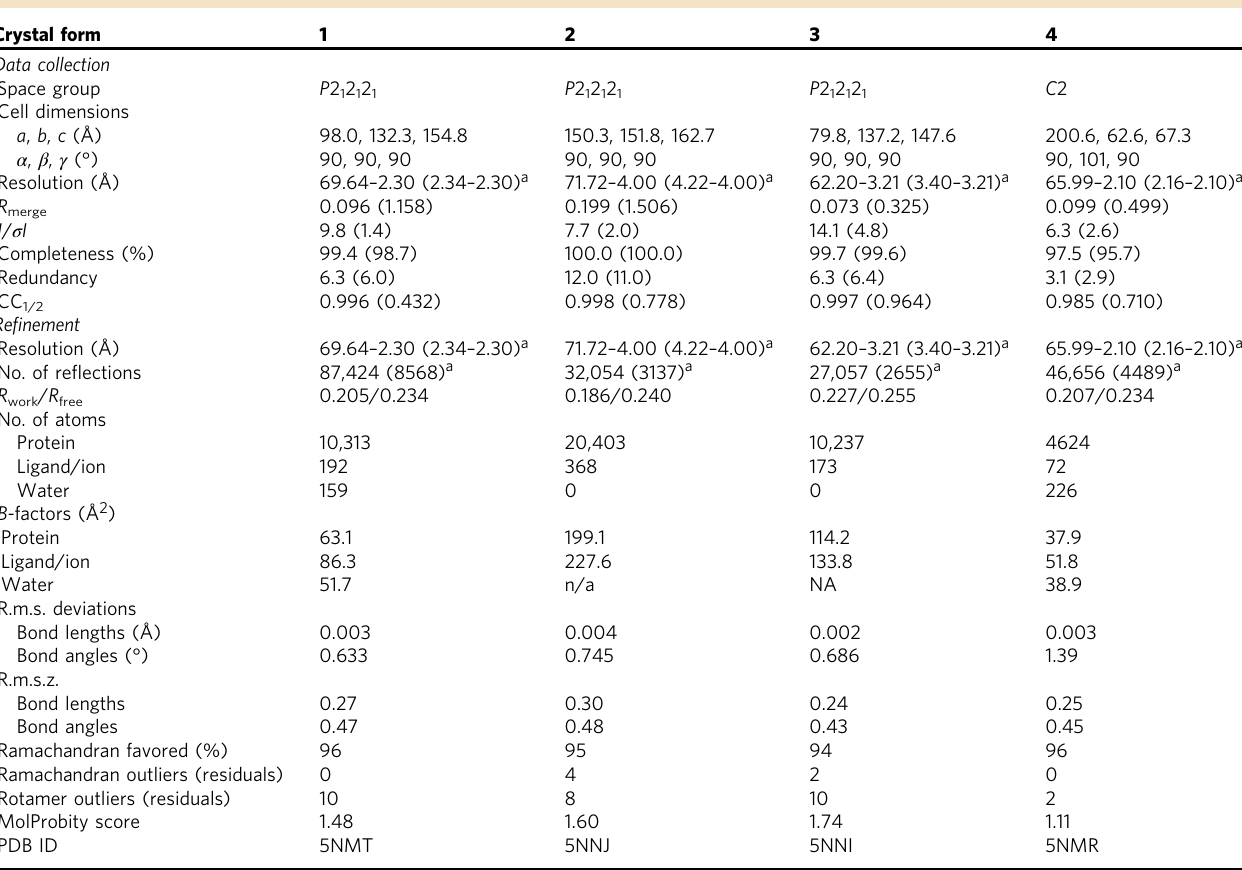
Table 1 Data collection and re fi nement